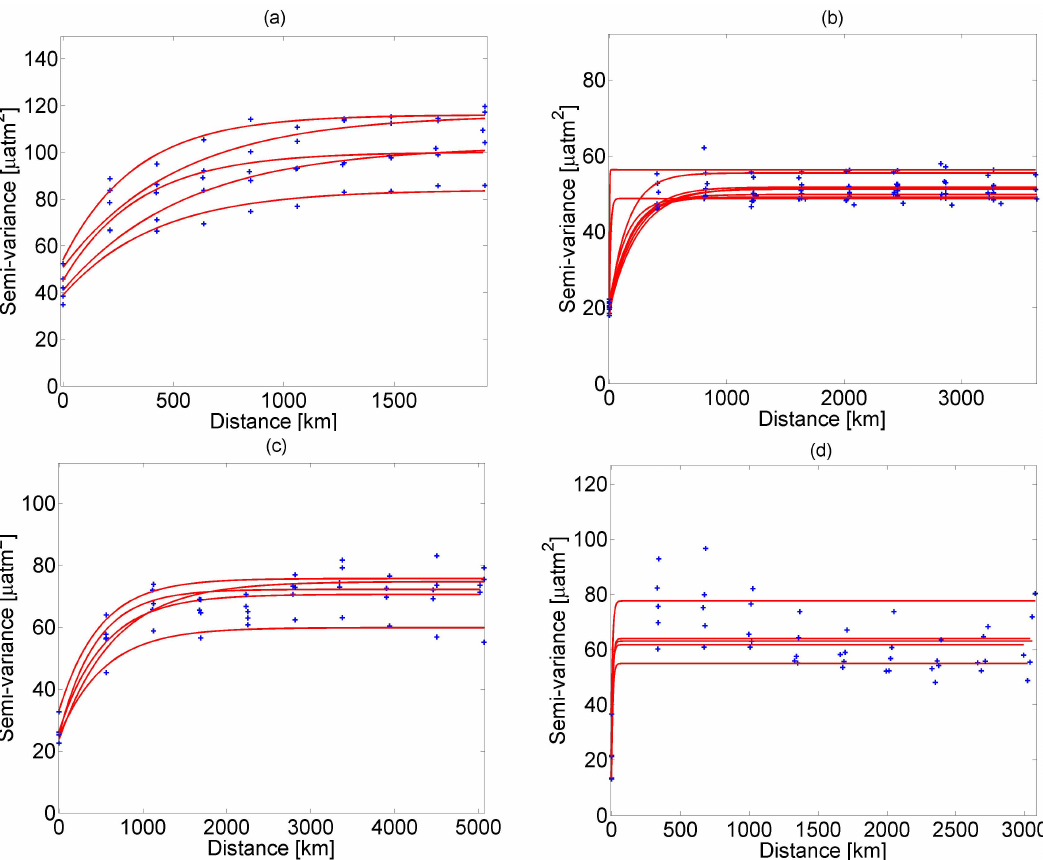
Fig. A1. Empirical semi-variograms of randomly chosen ensembles of the residuals as a function of distance in (a) the subpolar North Atlantic with a median decorrelation length of 430km, (b) subtropical North Atlantic with a median decorrelation length of 166km, (c) the equatorial Atlantic with a median decorrelation length of 530km and (d) the South Atlantic with a median decorrelation length of 9km. Region borders are listed in Table